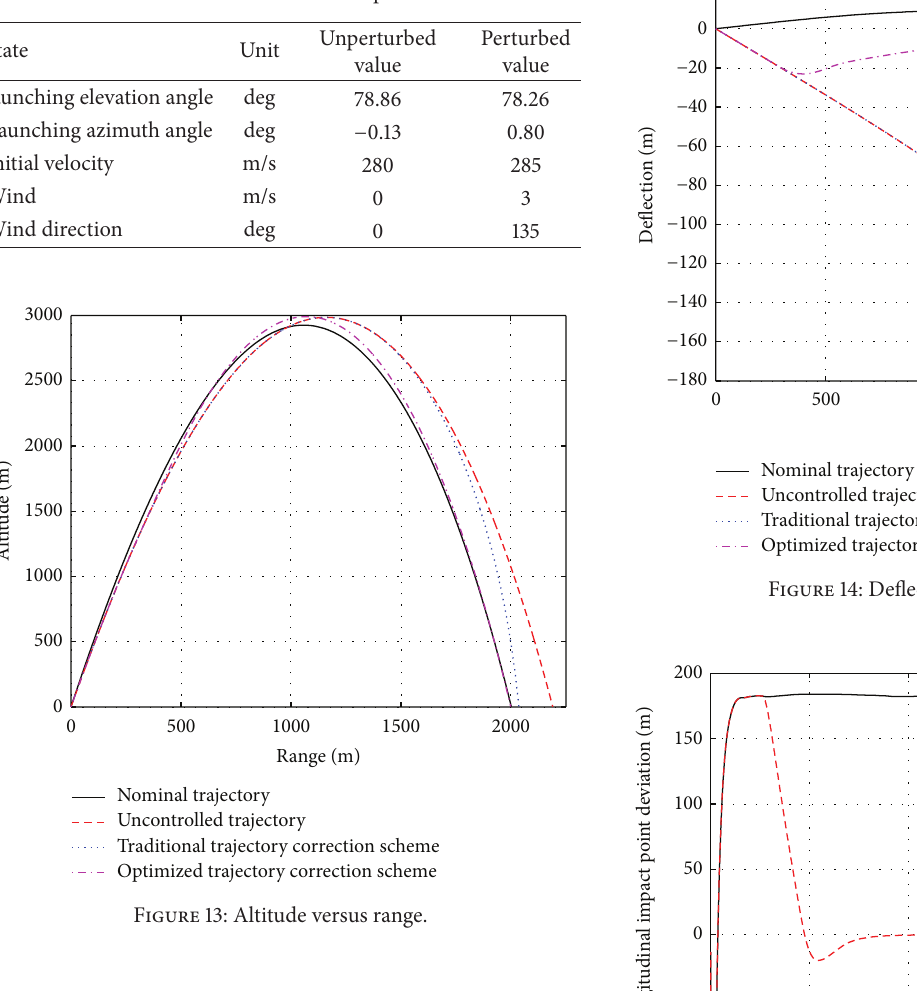
Table 1: Initial conditions for example simulation.